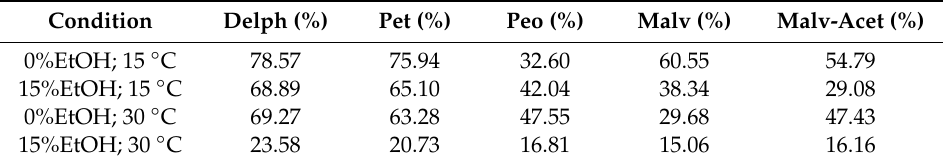
Table 2. Percentage of adsorption of individual anthocyanins at 120 min for CWM1.